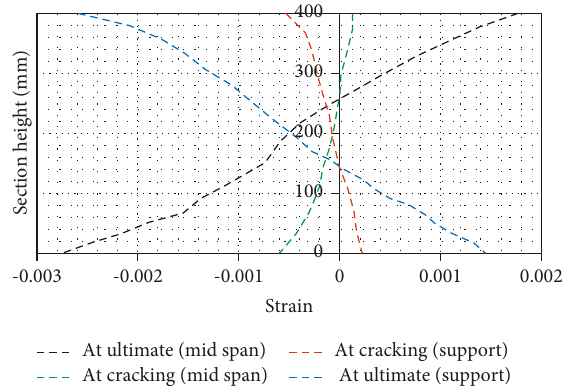
Figure 6: Strain distribution in the concrete section at support and